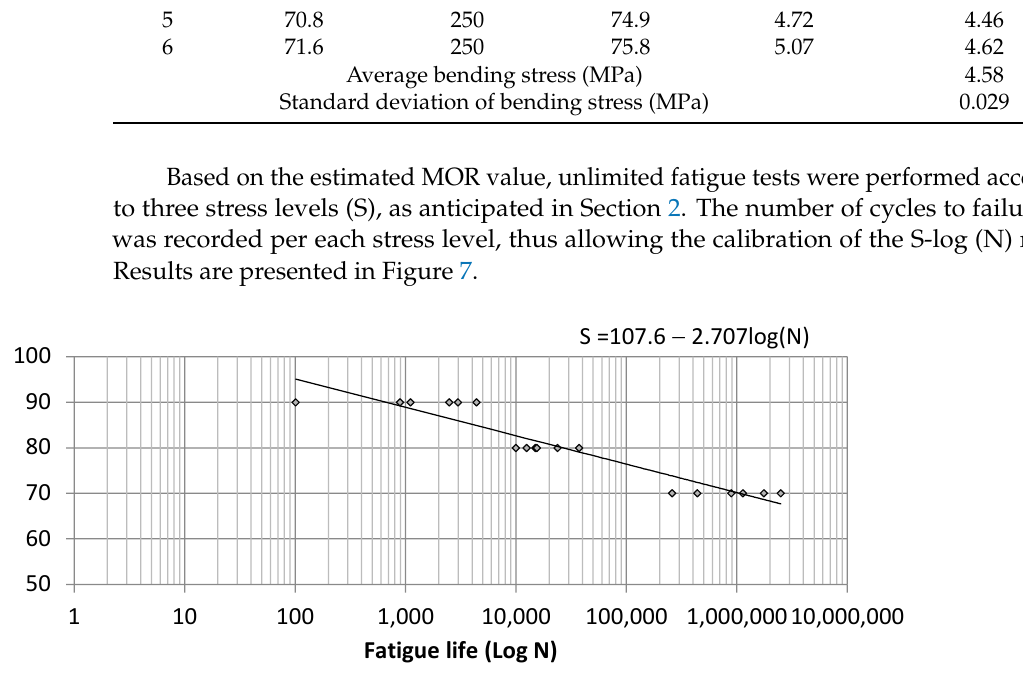
Figure 7. (S-log N) straight line interpolating the experimental data.